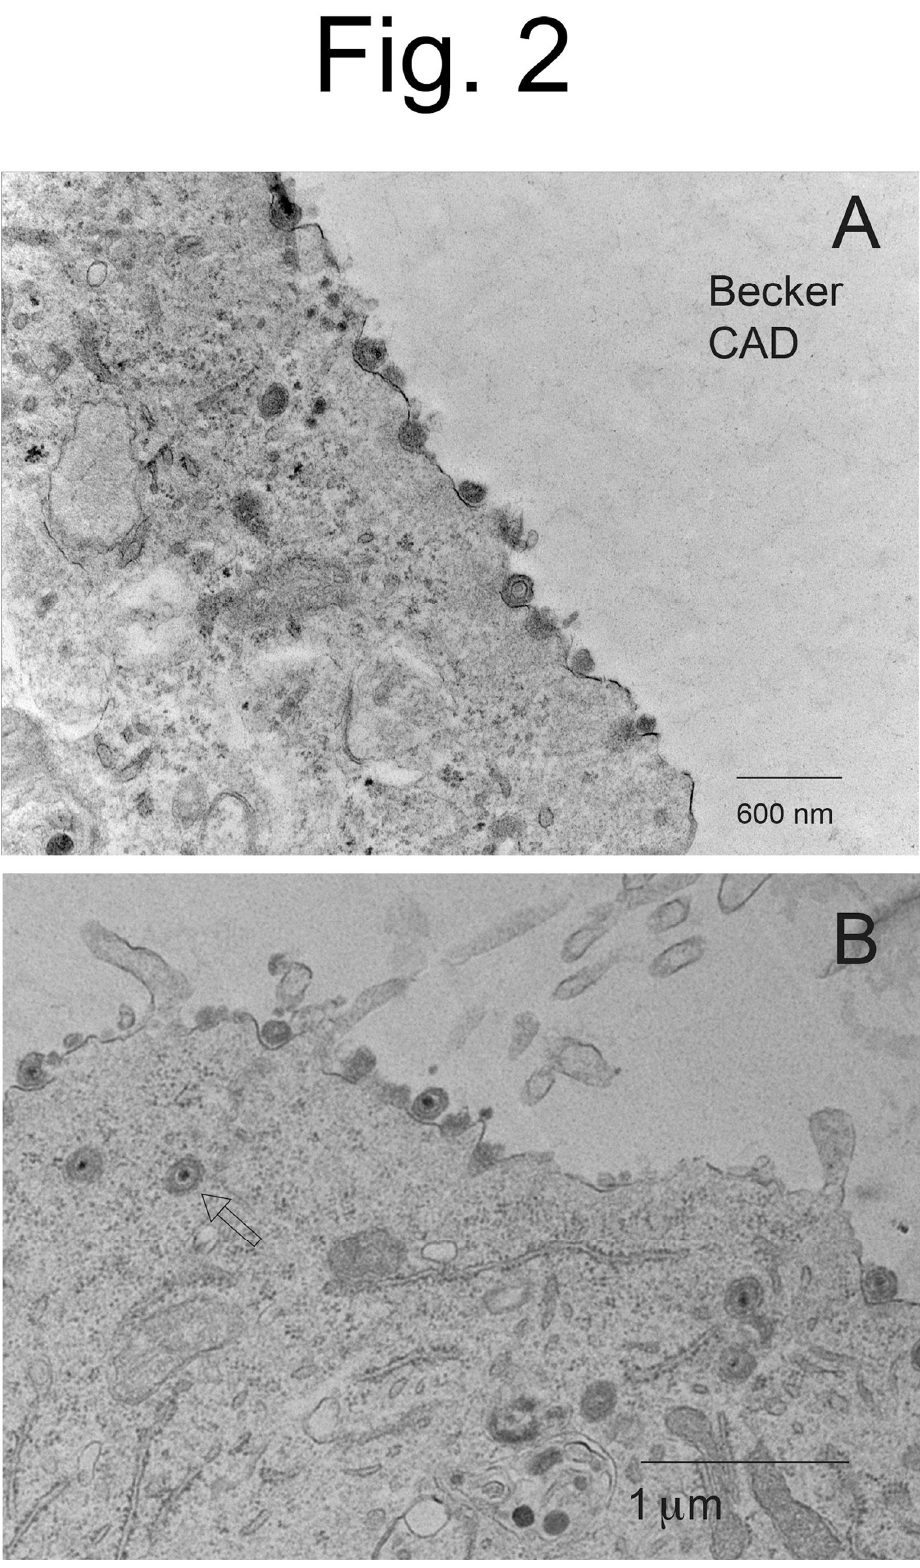
Figure 2. Higher magnification EM images of CAD neurons infected with wild-type PRV Becker. CAD neurons were infected with PRV Becker as in Figure 1 and processed for EM. Panel ( A ) shows cell surface virions. Panel ( B ) shows cell surface and cytoplasmic enveloped particles (empty arrow), which appeared of normal